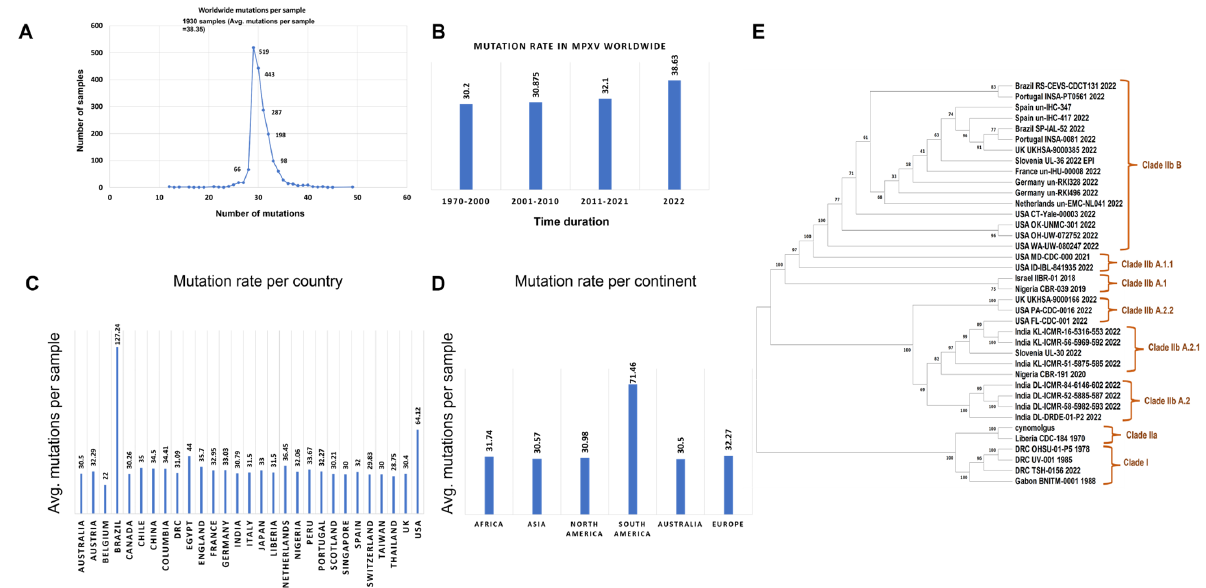
Figure 1. Distribution of the number of mutational events in the monkeypox genome sequences analyzed. ( A ) The average number of mutations per sample is 38.35 worldwide. ( B ) The mutations per sample of the MPXV outbreaks in 2021 and 2022. ( C ) The mutation events per country. ( D ) The distribution of the number of mutations for each sample per continent. ( E ) The maximum likelihood phylogenetic tree of the nucleotide sequences of the whole-genome MPXV strains selected from the collection date of 1962 to 2022 from the GISAID database across the world. The human MPXV genomes belong to clade IIb. The phylogenetic analysis was conducted using the maximum likelihood method with 1000 bootstraps.